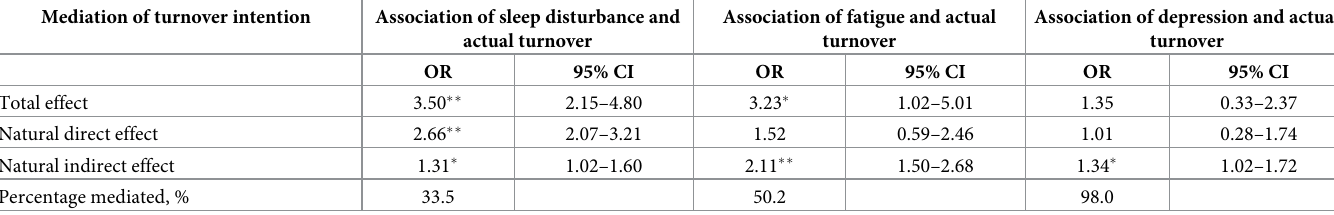
Table 4. The mediating effect of turnover intention in the relationship between health problems and actual